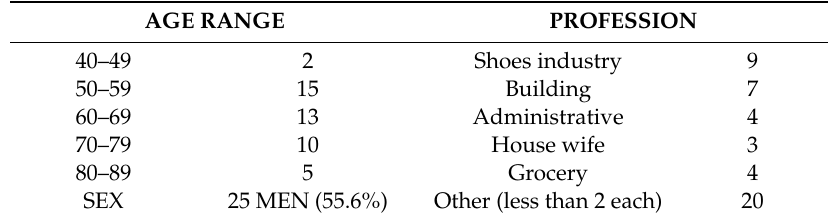
Table 1. Patient data. Summary of demographic data of patients (complete information is submitted as supplementary material Table